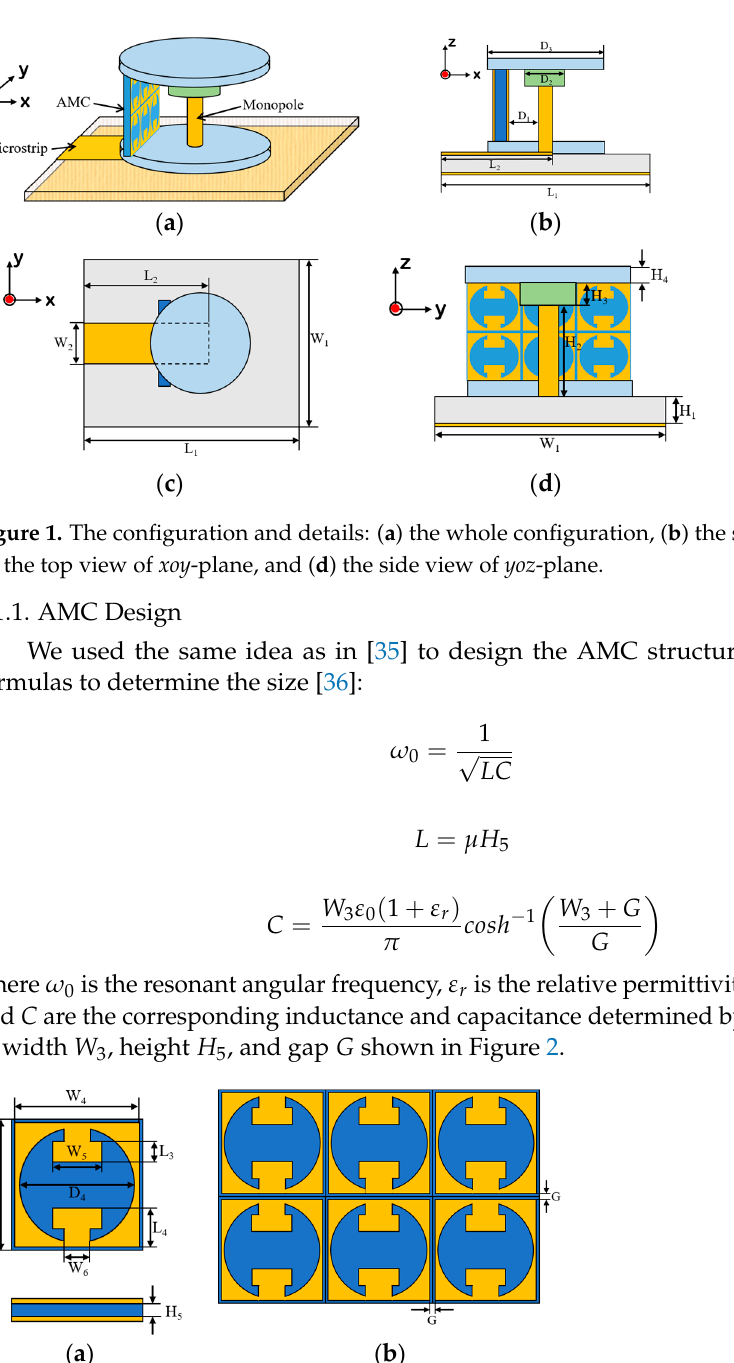
( b ) Figure 3. The reflection coefficients: ( a ) phase and ( b ) amplitude. 2.1.2. Monopole and Microstrip Line Designs Depending on the above design of the AMC structure, the monopole antenna was determined next. To reduce the height of the monopole antenna for 5.8 GHz radiation, the substrate top-loaded technique was employed. The top substrate with blue color in Figure 1 is TP1020, the permittivity is 10.2, and the loss tangent is 0.0015. Another substrate below is FR4, which has a permittivity of 4.4 and a loss tangent of 0.025. At the bottom of the monopole, there is one blue substrate, which is the same as the top-loaded one. The main purpose is to fix the monopole and form the button shape. One piece of conventional cylindrical copper with a diameter of 1.4 mm was selected as the radiator of the antenna and then combined with the above materials. We designed a monopole antenna resonating around 5.8 GHz. In order to obtain good matching for the antenna, an all-fabric quarter-wave transformer composed of a microstrip line was de- signed. The substrate is 100% cotton with a thickness of 1.5 mm; the permittivity and the loss tangent are 1.6 and 0.02, respectively. The conductive textile of the microstrip line is a composite of nickel and copper with a resistivity of about 0.05 Ω ∙ m . Furthermore, the strip of the microstrip line, taken as the feeding, connects to the cylindrical copper. The final values of both the monopole and the microstrip line are listed in Table 2.